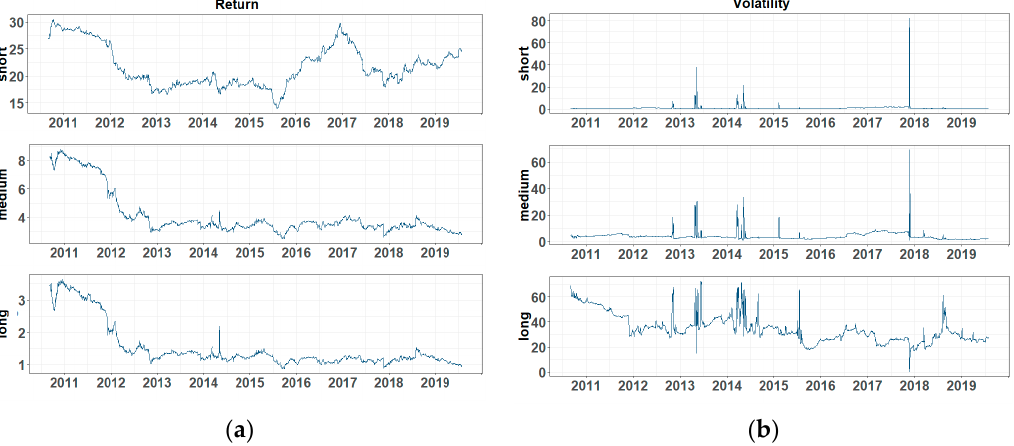
Figure A3. Frequency decomposition of dynamic connectedness: ( a ) frequency decomposition of total connectedness for return series and ( b ) frequency decomposition of total connectedness for volatilities. Note: BRL, RUB, INR, CNH, and ZAR are Brazilian Real, Russian Ruble, Indian Rupee, o ff shore Chinese Yuan, and South African Rand, respectively. GASF is the Henry Hub natural gas futures